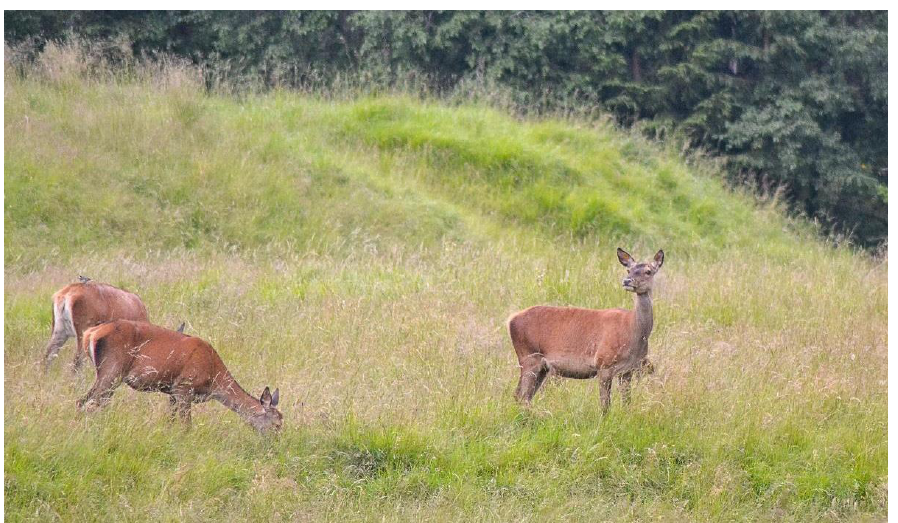
Figure 6. A female sentinel remains in an alert state while the other females eat. Males and females had completely different reactions to disturbances. With good vis- ibility conditions, the closest approach distance inside the enclosure to the males’ group was in fact ca. 7 m, while that to the nursery group was ca. 60 m; distances were recorded with a measuring tape after the observation sessions. The two groups also had different flight strategies. The males tended to frequently stop during the flight to check the dis- turbance source (Figure 7), while the nursery group, after initiating a flight, ran away im- mediately without stopping until a safe spot was reached. Moreover, other differences within the groups were noticeable. In the male group, the last one fleeing was always the dominant one, which was also the least sensitive to disturbances. In the nursery group, the females without fawns were less sensitive to disturbances.